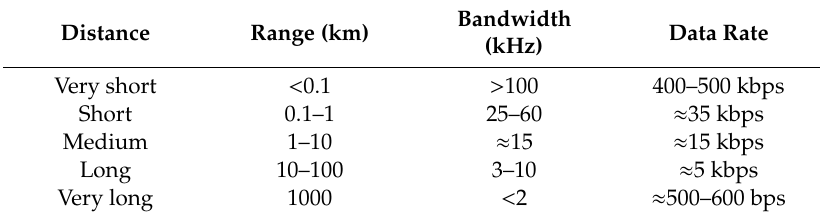
Table 1. The bandwidth of di ff erent acoustic communication links [5,6].